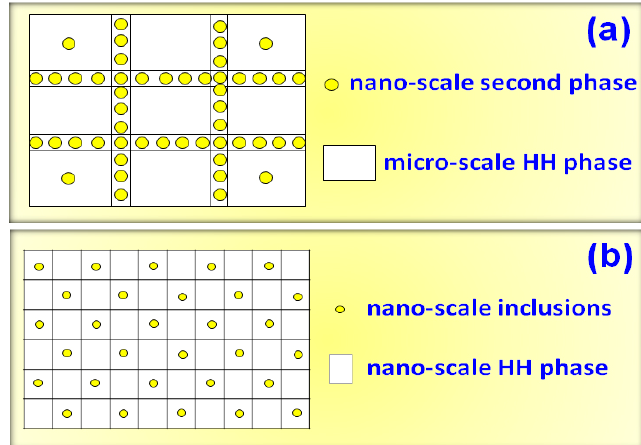
Figure 4. Two types of HH nanocomposites: ( a ) micro-scale HH matrix with nano-scale inclusions; ( b ) nano-scale HH phase with